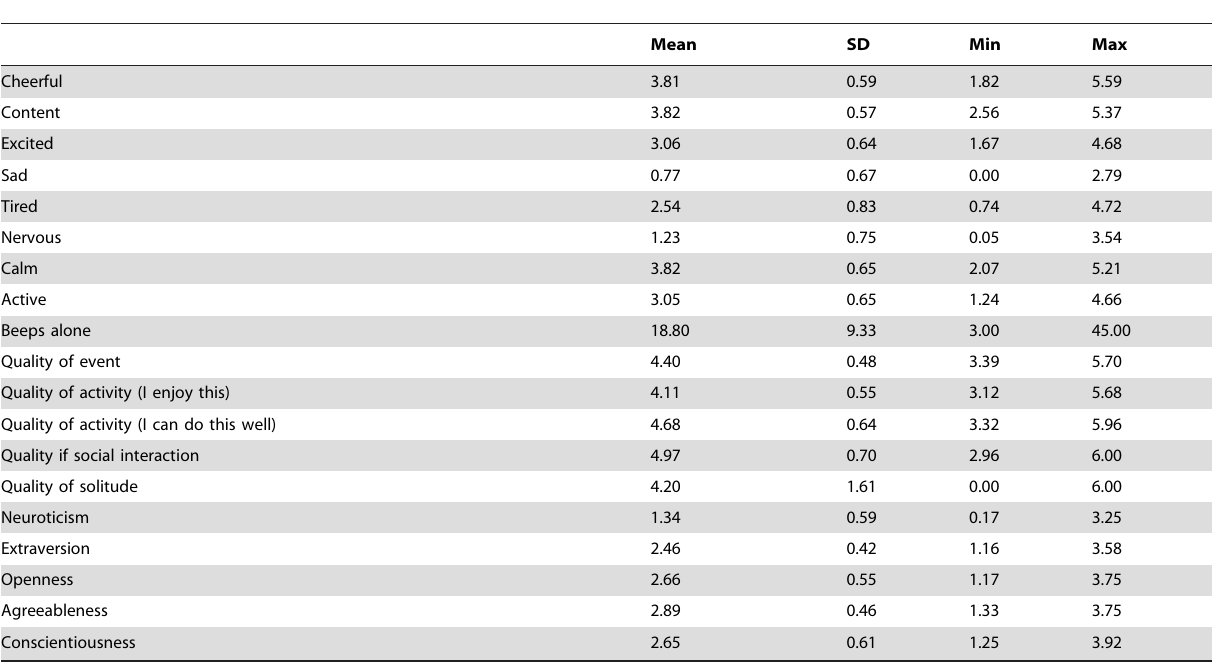
Table 1. Descriptive statistics for ESM measurements and Five Factor personality features.